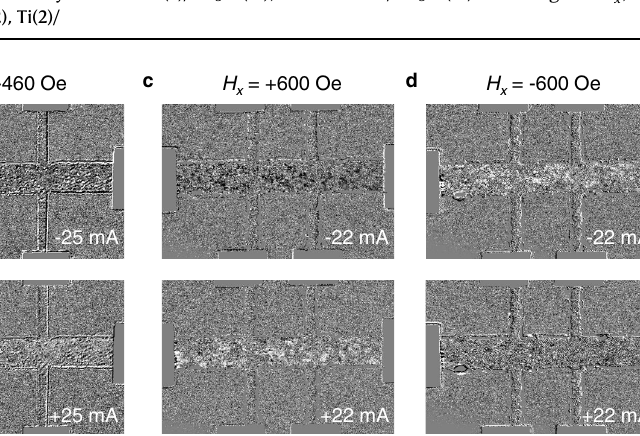
Mn 3 Sn(12), and Substrate/Mn 3 Sn(12) with a positive in-plane assistant fi eld H x , respectively. c , f , i Current dependence of Hall resistance of MgO(3)/Mn 3 Sn(12), Ti(2)/Mn 3 Sn(12), and Substrate/Mn 3 Sn(12) with a negative H x ,